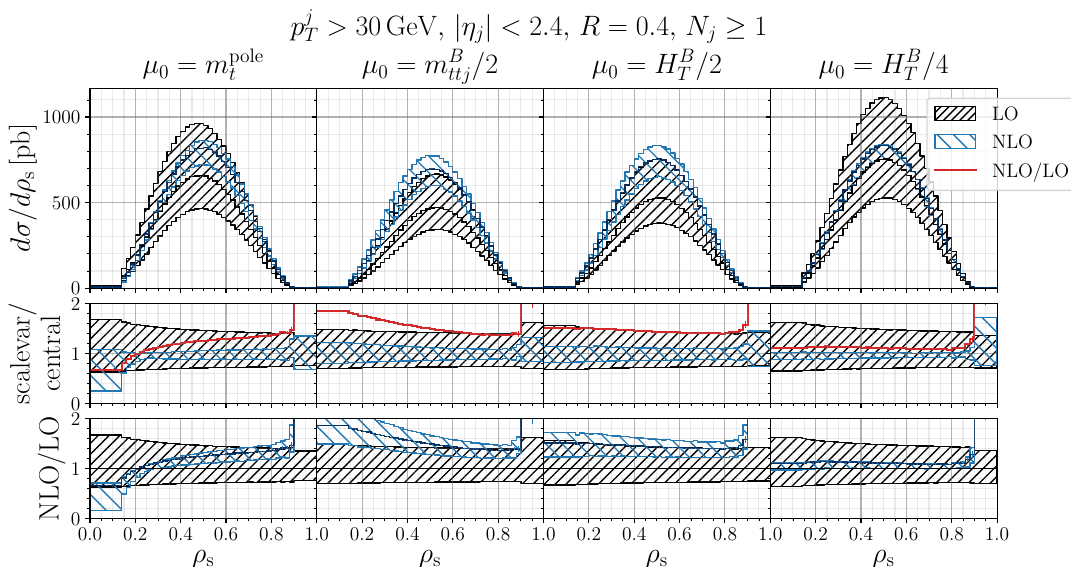
Figure 7 . Central predictions for the ρ s distribution at NLO (blue) and LO (black), together the corresponding NLO and LO seven-point scale variation uncertainty bands, using as a central scale µ 0 = m t , m B / 2 , H B / 2 and H B / 4 (from left to right). In the middle ratio plot the scale T T t ¯ tj variation uncertainty at either NLO or LO is rescaled by the central scale prediction at NLO or LO respectively. To visualize the difference between the NLO and LO differential cross section the ratio of the NLO and LO central scale predictions is shown in red. In the bottom ratio insets both the NLO and LO scale variation uncertainty bands are rescaled by the LO central scale